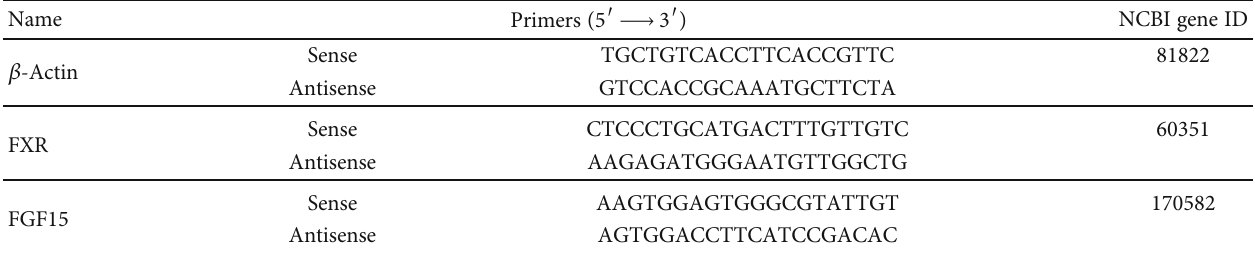
Table 1: The speci fi c primers used for ampli fi cation.